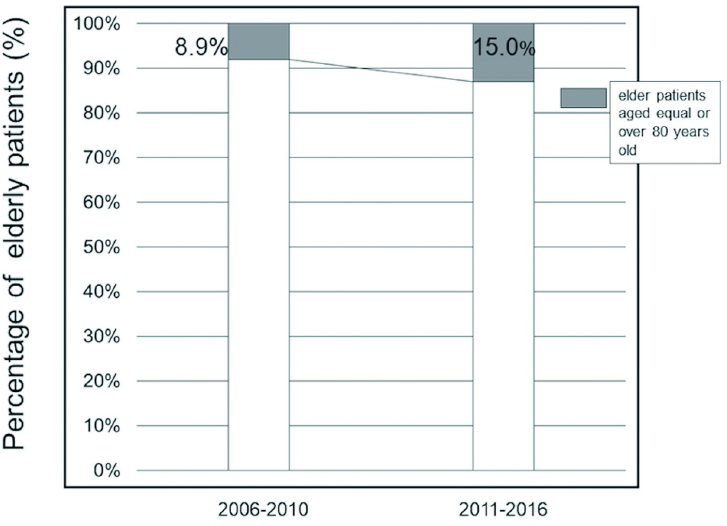
Fig 3. Bar graph showing the percentage of patients in the study aged � 80